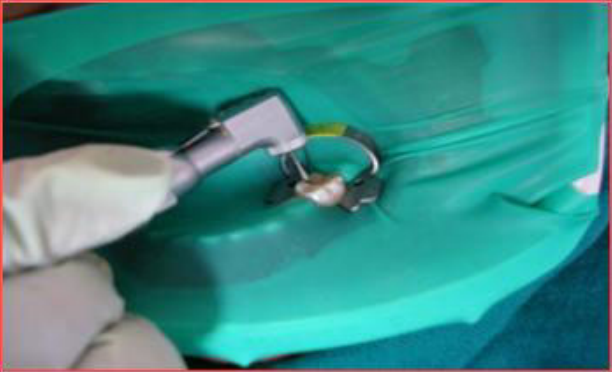
Fig. 5 - Alfa hemolytic colonies on blood agar plate